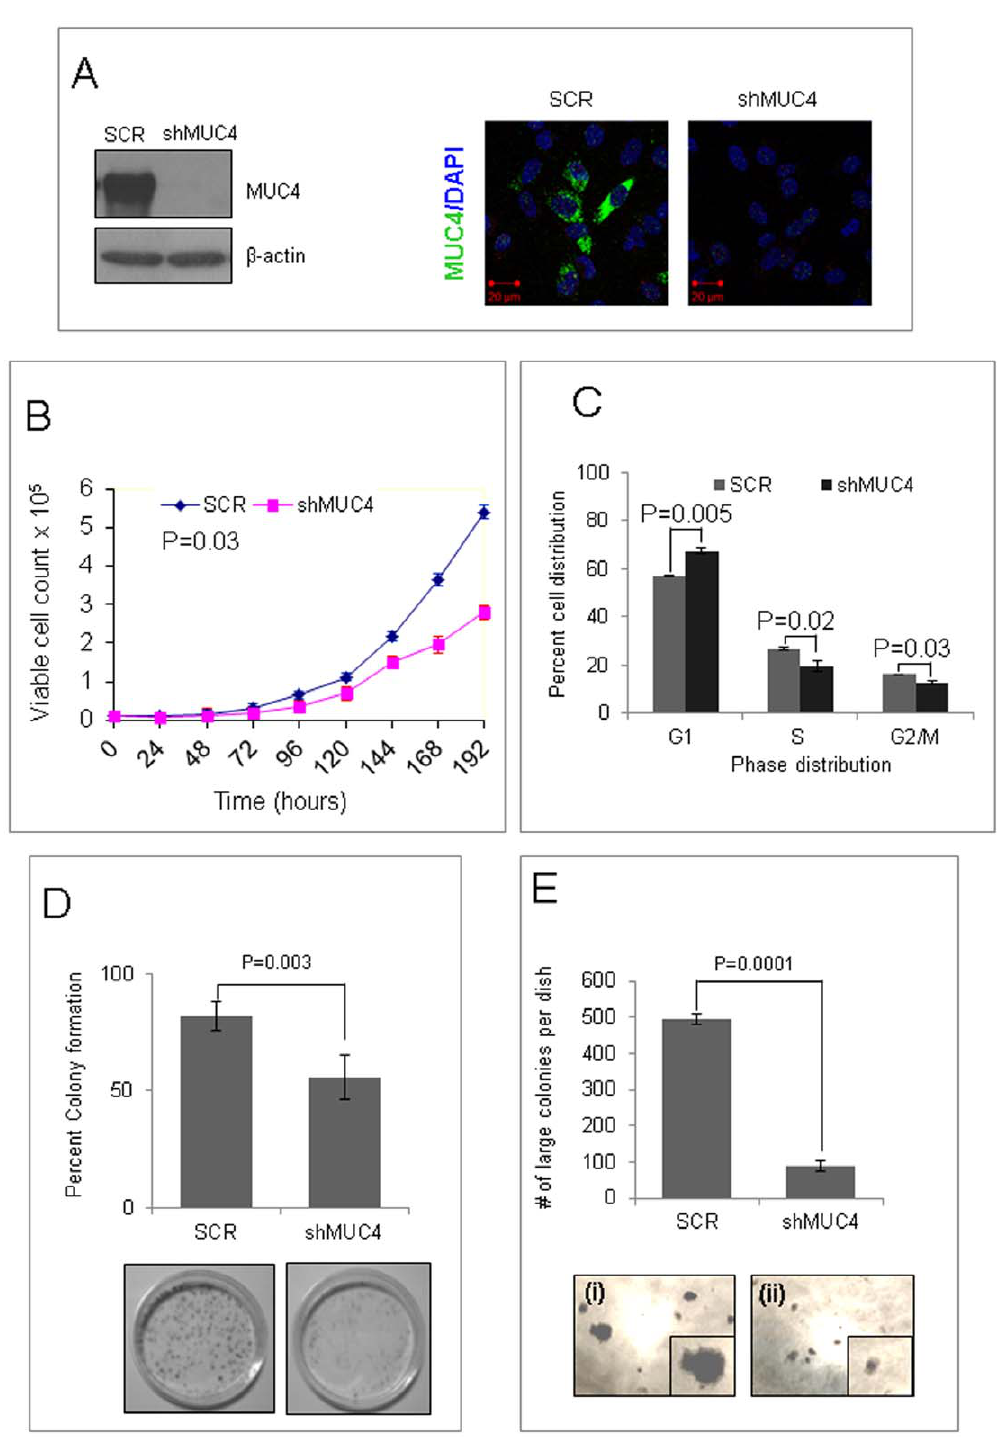
Figure 1. MUC4 promotes proliferation and growth of MDA-MB-231 cells. ( A ) Detection of MUC4 protein expression in control (MDA-MB- 231-SCR) and MUC4 knockdown (MDA-MB-231-shMUC4) cells. Immunoblot showed reduced expression of MUC4 in MDA-MB-231-shMUC4 cells compared to control cells. Immunostained cells using human anti-MUC4 mouse monoclonal antibody (8G7) showed reduced expression of MUC4 in MDA-MB-231-shMUC4 cells compared to control cells. ( B ) In proliferation analyses, when the number of cells was plotted against the incubation period (hours), control cells showed a significantly higher proliferation rate than MUC4 knockdown cells, p=0.03. Population doubling time of control cells was less than MUC4 knockdown cells when calculated from the number of cells growing in log phase (day 2 to 6) using the formula, T d =0.693t/ ln (N t /N 0 ). ( C ) Cells, following synchronization and serum re-stimulation and stained with Telford reagent (containing propidium iodide) and analyzed by FACS, showed that the number of MUC4 knockdown cells in the G1 phase was higher than control cells suggesting the inhibition of cell cycle progression. ( D ) The colony forming ability of control cells was higher than MUC4 knockdown cells under anchorage-dependent conditions. After staining, colonies of . 50 m m in size were counted using Quantity One software, p=0.003. Images of anchorage–dependent growth assays were